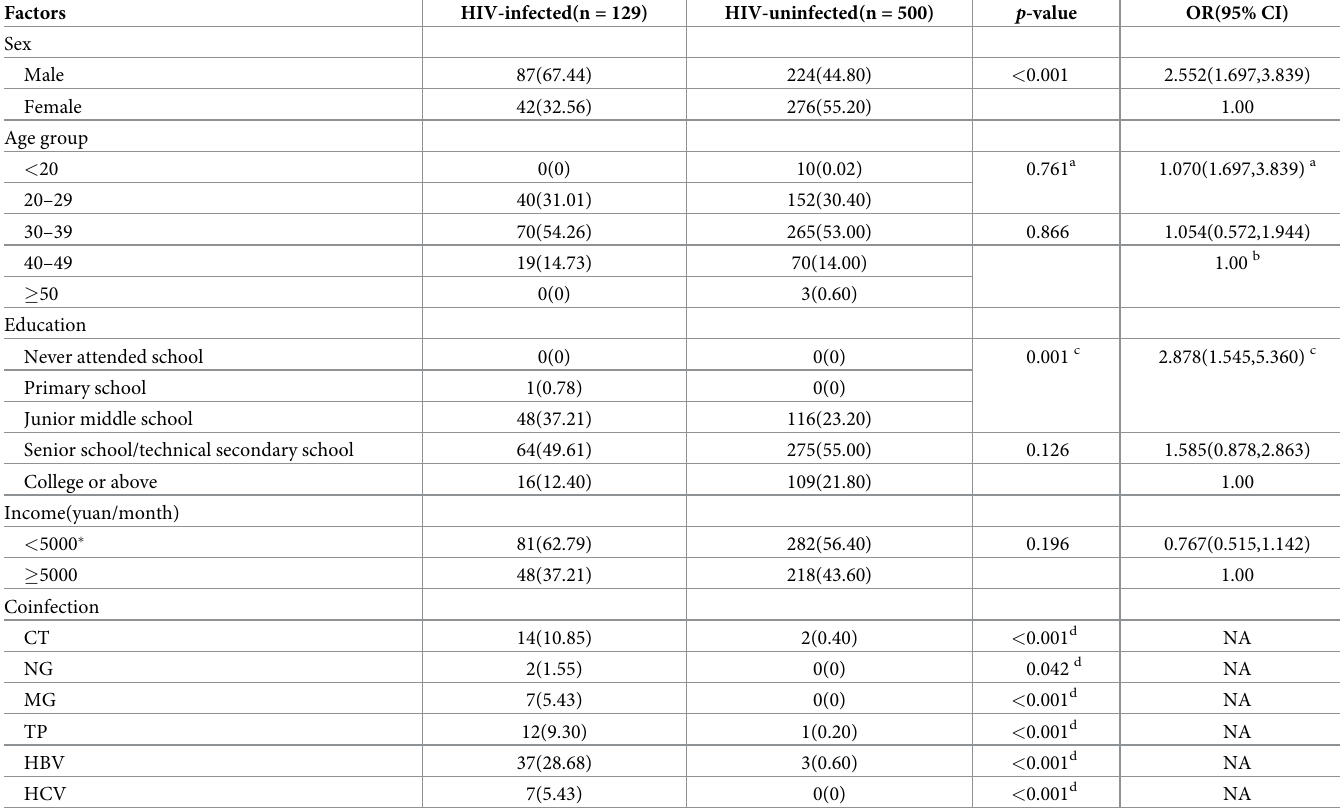
Table 4. Risk factors in HIV-infected or HIV-uninfected among infertile couples in Hunan, China.